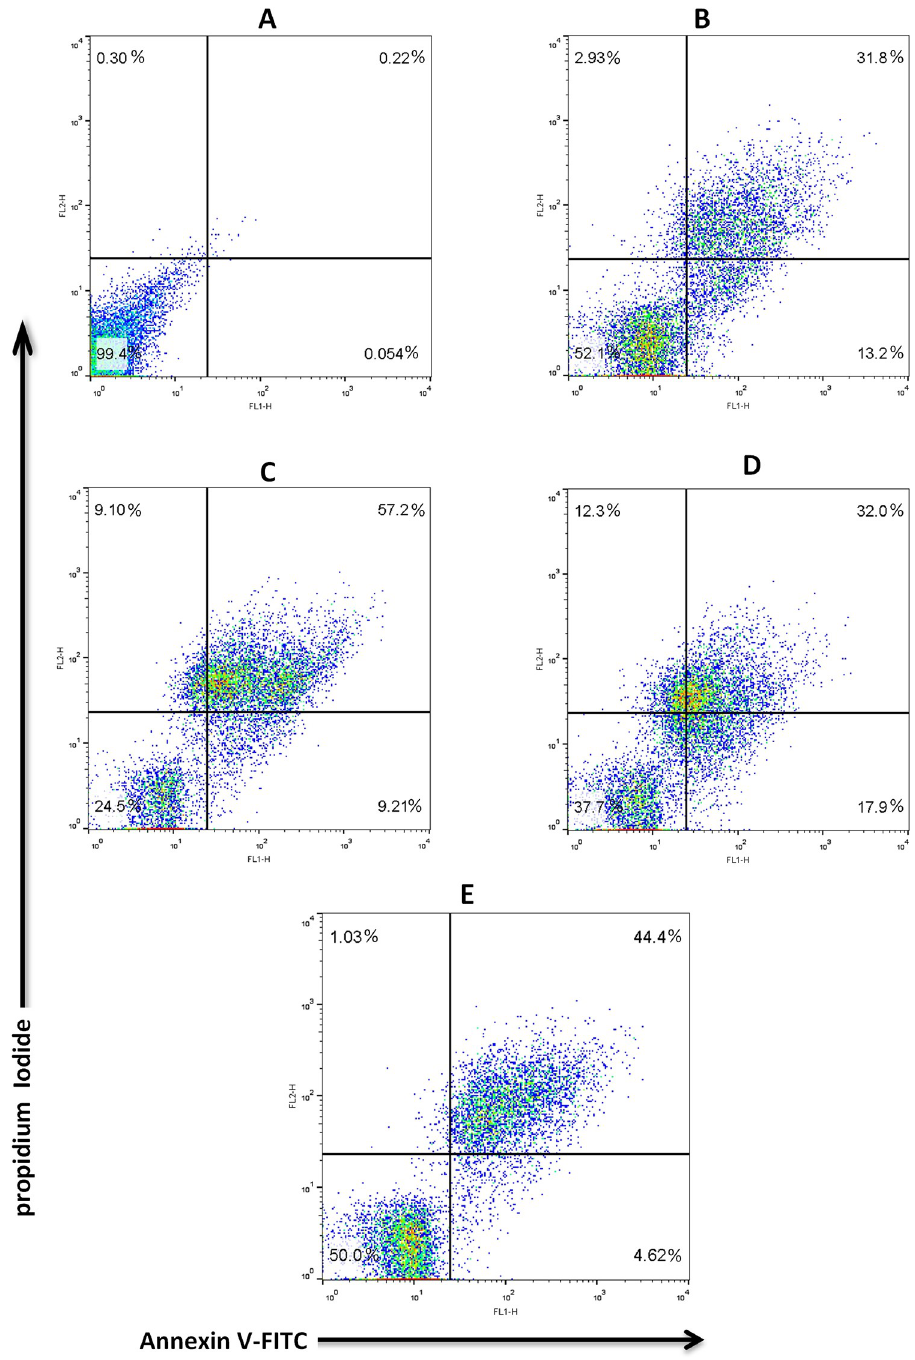
Fig 8. The sperm apoptosis in the cryopreservation process was assessed using Annexin V FITC and PI. Unstained sperm (panel A), a fresh control panel (B), a frozen control (panel C), Frozen trehalose (panel D), and a frozen gentiobiose (panel E) are presented in the graph. The top left quadrant shows necrotic cells; the lower left quadrant shows live cells; the lower right quadrant and the top right quadrant represent early apoptotic and late apoptotic cells,